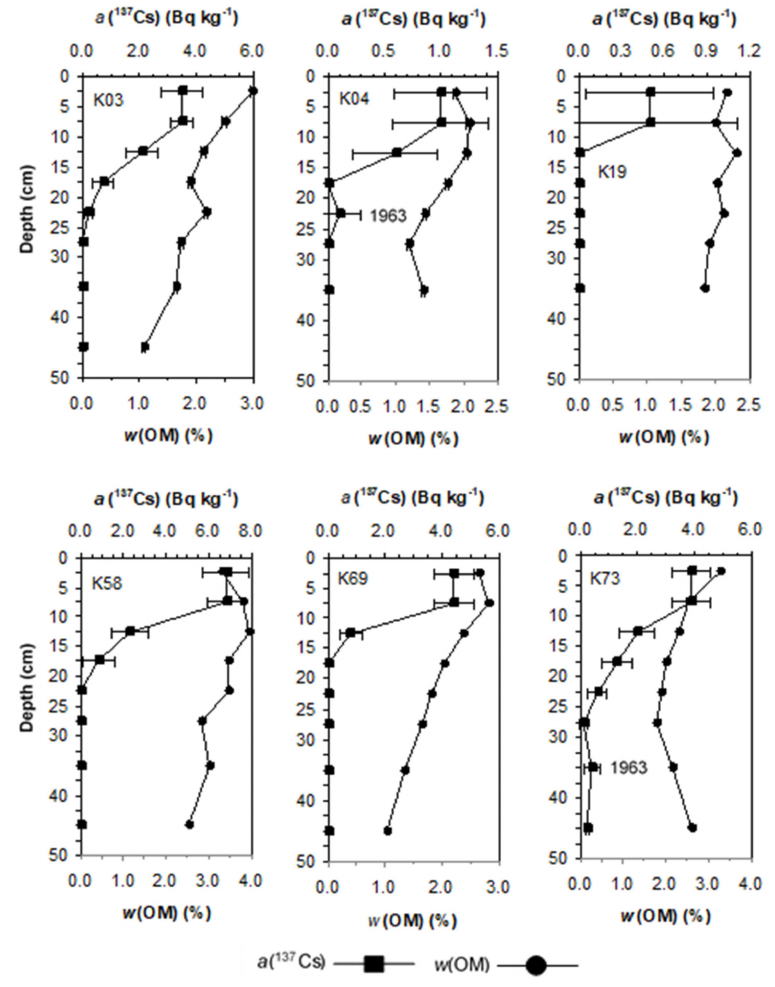
Figure 7. 137 Cs massic activity profiles with uniform 137 Cs activities in surface sediment and organic matter mass fraction profiles. Measurement uncertainties are expressed with k = 2 for normal